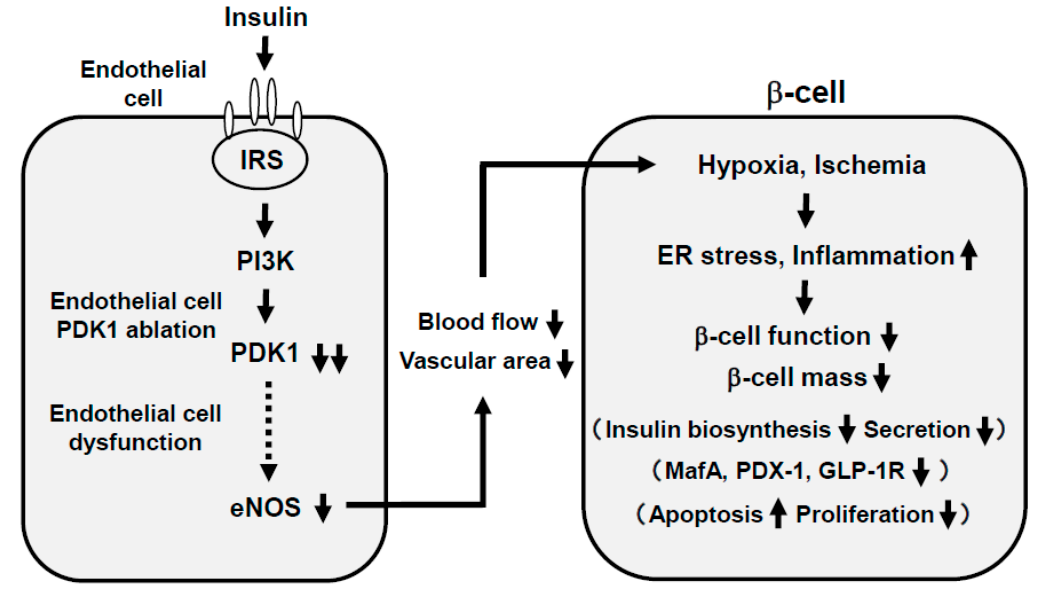
Figure 3. Association of endothelial cell dysfunction with pancreatic β -cell dysfunction: Involvement of hypoxia, provoked endoplasmic reticulum (ER) stress, and inflammatory reaction. Ablation of endothelial PDK1 reduces vascularity in islets, and both pancreatic and islet blood flow are decreased, which lead to hypoxia in islets and induction of ER stress and inflammation. Therefore, it is likely that vascular endothelial PDK1 plays an important role in the maintenance of pancreatic β -cell mass and function by maintaining the vascularity of the pancreas and islets and protecting them from hypoxia, ER stress, and inflammation.